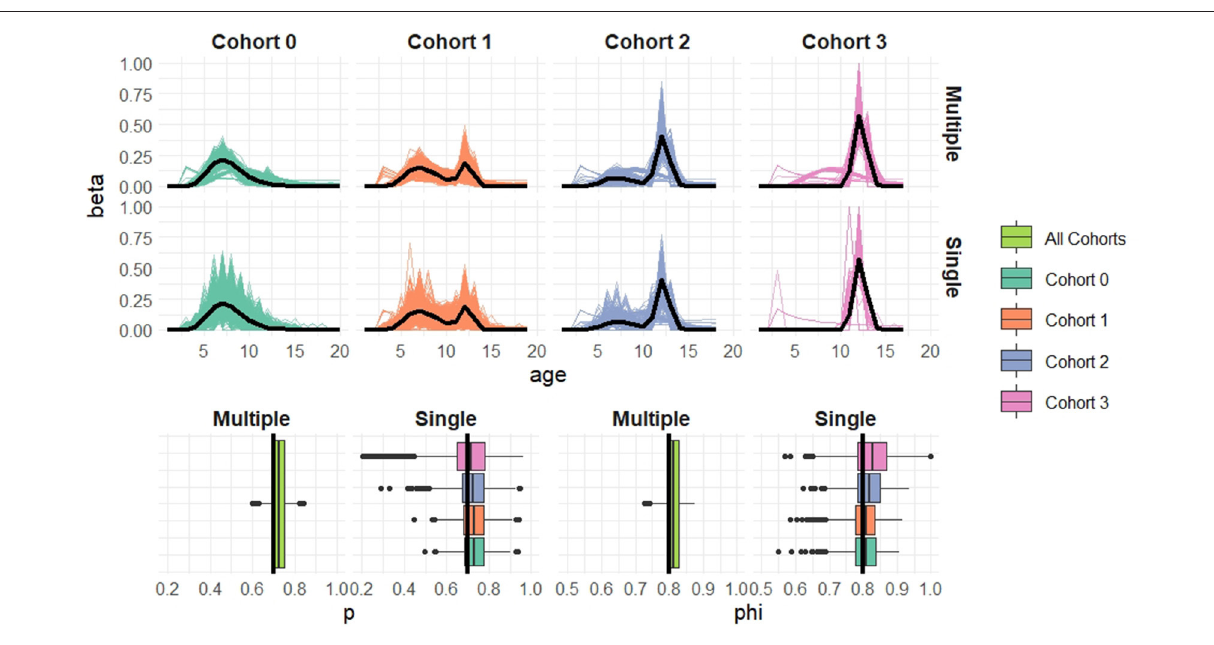
FIGURE 4 | Simulation results when cohort sample size n = 20 based on 1,000 simulated datasets. Top : Estimated recruitment distributions from the cohort-structured model. Middle : Estimated recruitment distributions from the single-cohort models. Bottom : Estimated capture and survival probabilities for the cohort-structured model (multiple) and separate single-cohort models (single). The true values are indicated by black